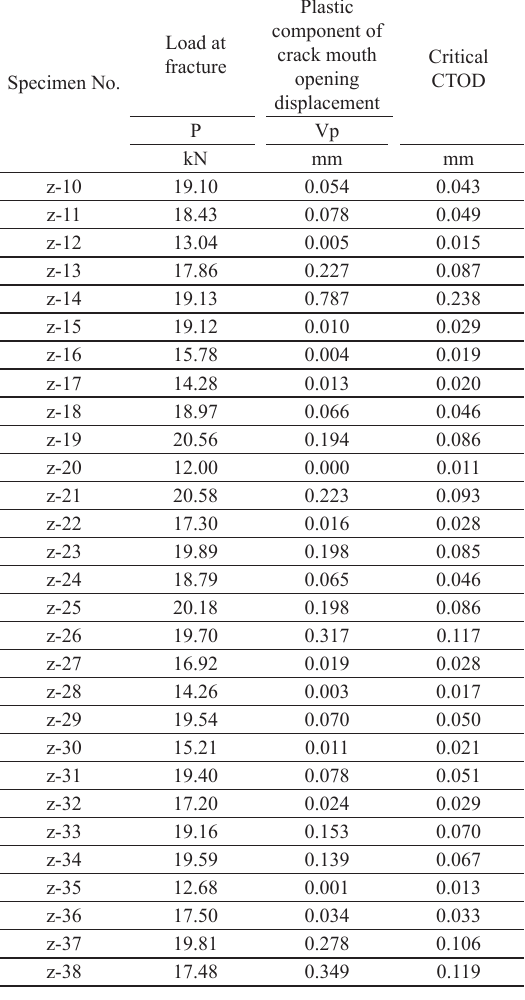
Table 2. List of critical CTOD values and plastic component.